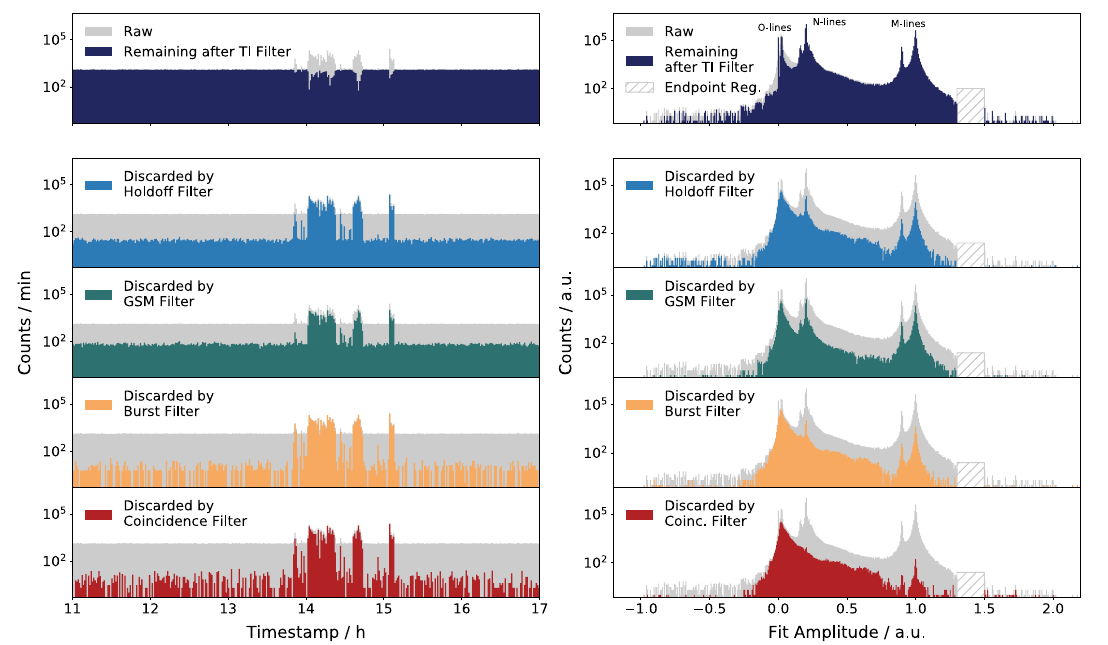
Fig. 5 Histograms to illustrate the influence of the time information filter, broken down by the four independent subfilters. Left: histograms of the number of acquired traces per minute. From a two-day dataset of ECHo run 24, a six hour sample containing high levels of noise between the timestamps 13.5h and 15.5h is shown. Right: histograms